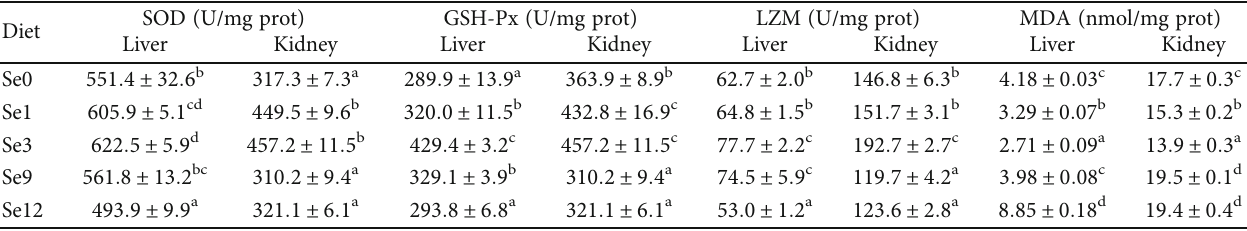
Figure 2: Outputs of nitrogen waste (NW) and phosphorus waste (PW) from aquaculture of juvenile triangular bream ( Megalobrama terminalis ) that fed the test diets for 8 weeks. Data were expressed as mean ± SD ( n = 3 ), the columns represent mean value, and the error bars represent SD. Date with di ff erent letters are signi fi cantly di ff erent at P < 0 : 05 . Table 5: E ff ects of selenium yeast on activities of SOD, GSH-Px, and LZM and content of MDA in the liver and kidney of juvenile triangular bream ( Megalobrama terminalis ) fed the test diets for 8